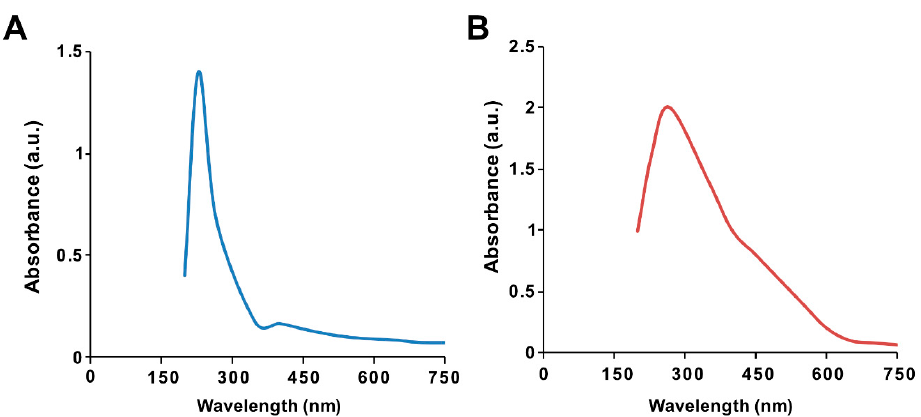
Figure 1. Synthesis and characterization of graphene oxide (GO) and graphene oxide–green platinum nanoparticles (GO-PtNPs). Ultraviolet–visible spectroscopy of GO ( A ) and GO-PtNPs ( B ). At least three independent experiments were performed for each sample and reproducible results were obtained.